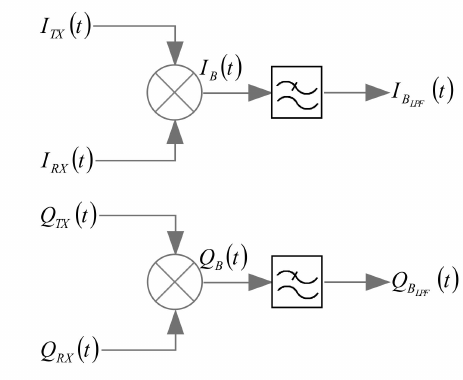
Figure 2. I / Q component extraction for phase